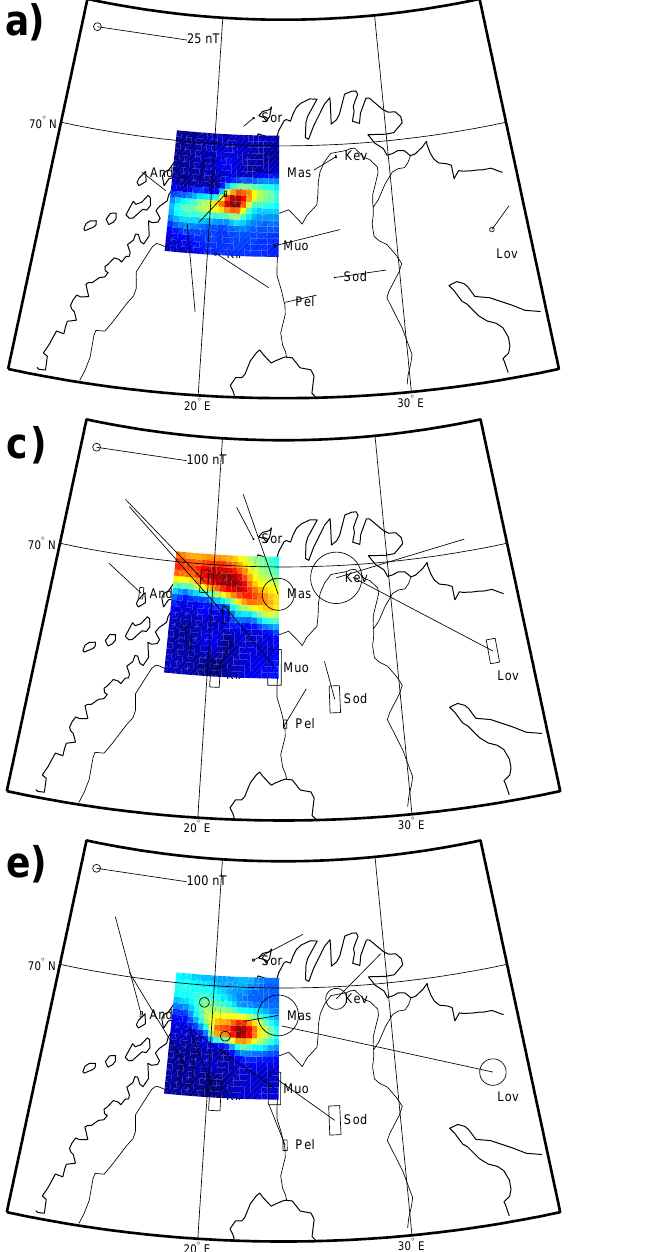
4 π · 10 − 7 H/m and R = 6 H /6 P is the Hall to Pedersen conductance